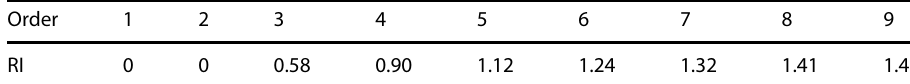
Table 4 RI average random consistency